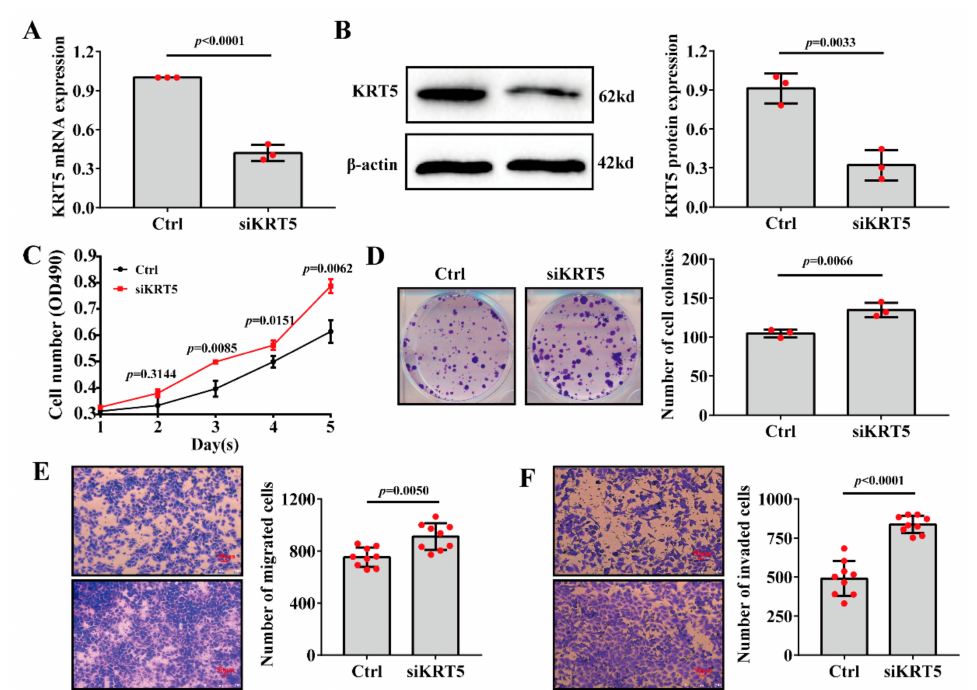
Figure 6. KRT5 knockdown promoted the proliferation and metastasis of A375 cells. ( A , B ), Successes of KRT5 knockdown in A375 cells following transfection with the KRT5 -specific-siRNAs, as examined by qRT-PCR assay ( A ) and western blotting ( B ). ( C ) KRT5 knockdown accelerated cell proliferation of A375 cells, as examined by MTT assay. ( D ) KRT5 knockdown promoted cell colony formation of A375 cells, as detected by cell colony formation assay. ( E , F ) KRT5 knockdown enhanced the cell migration ( E ) and invasion ( F ) of A375 cells, as detected by Transwell assay. Data are means ± s.d., n ≥ 3; p value < 0.05 was considered significant, t